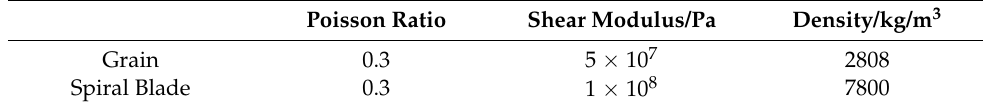
Table 3. Physical parameters of crushed stone aggregate and spiral.